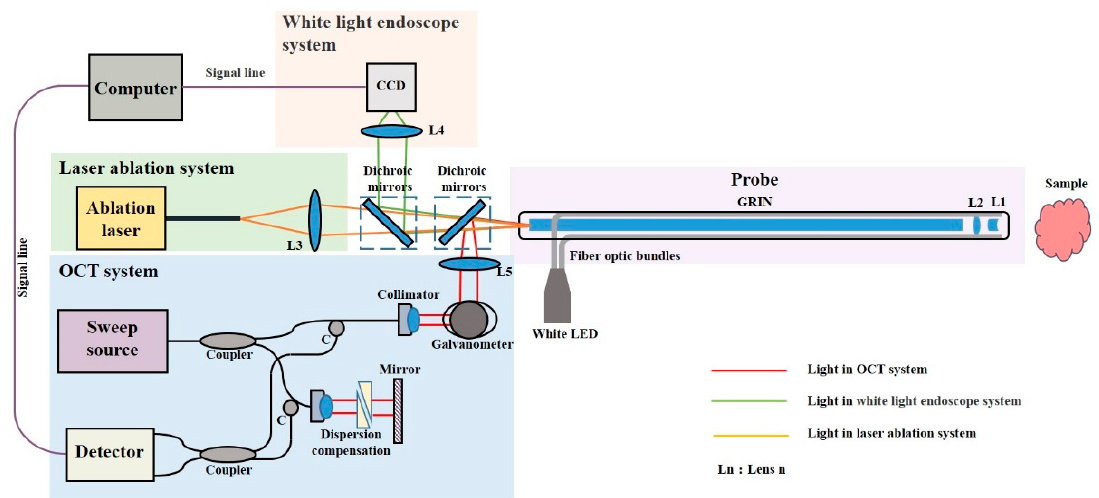
Figure 1. Schematic of the integrated multifunctional laryngoscope. L#: lens; GRIN: Gradient-index lens; CCD: charge-coupled device; C: circulator.